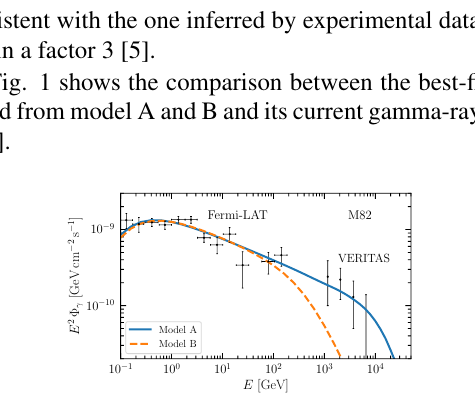
Figure 1. Comparison between the gamma-ray best fit from model A and model B for M82 and its gamma-ray data [7, 9]. Figure taken from Ref. [5].